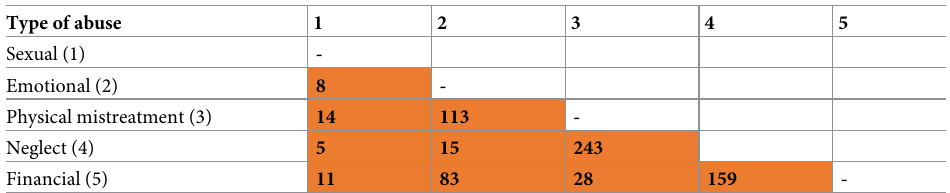
Table 3. Participants experiencing two types of